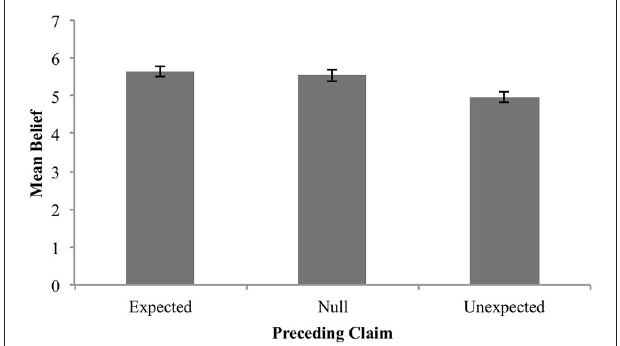
FIGURE 10 | Mean belief in claim by expectedness condition. Error bars are standard